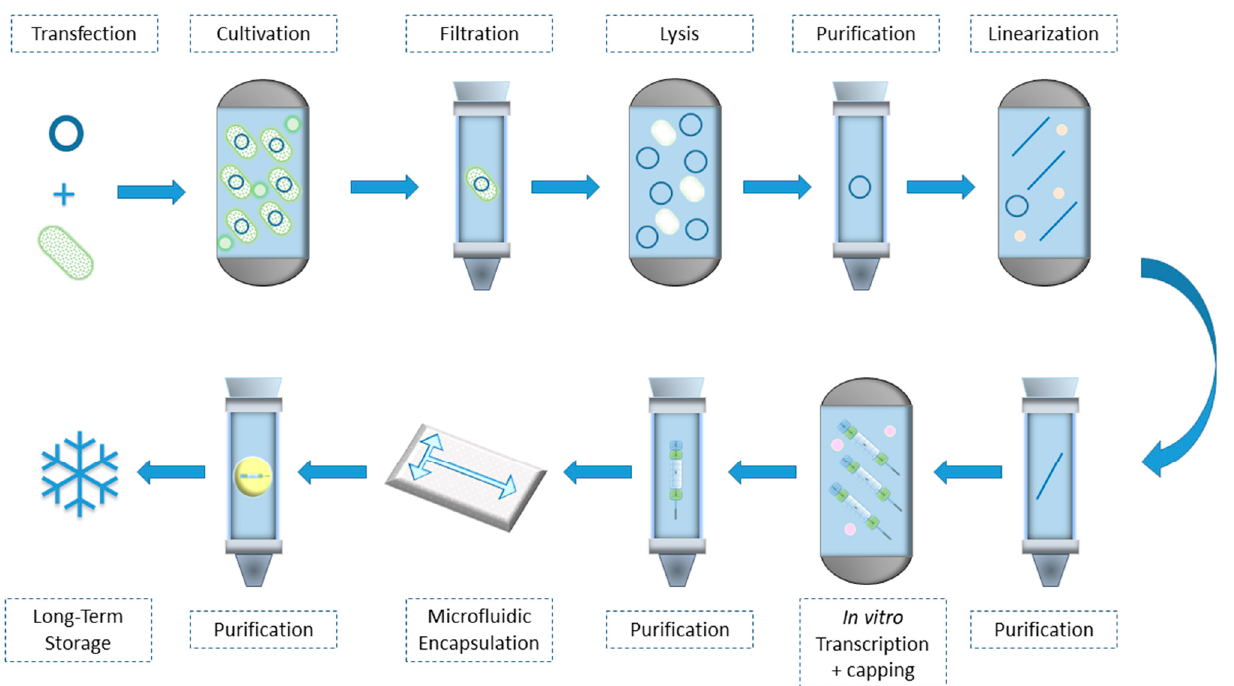
Figure 2. Production of mRNA on an industrial scale starting from bacterial transfection with the vector containing the DNA from which mRNA will be synthesized, down to its formulation with a delivery vector and long-term storage.